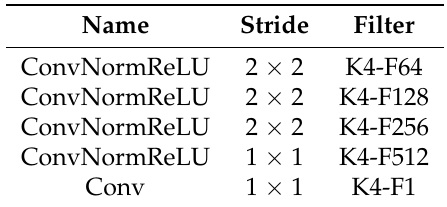
Table A2. Discriminator for both 128 × 128 and 512 × 512 images.